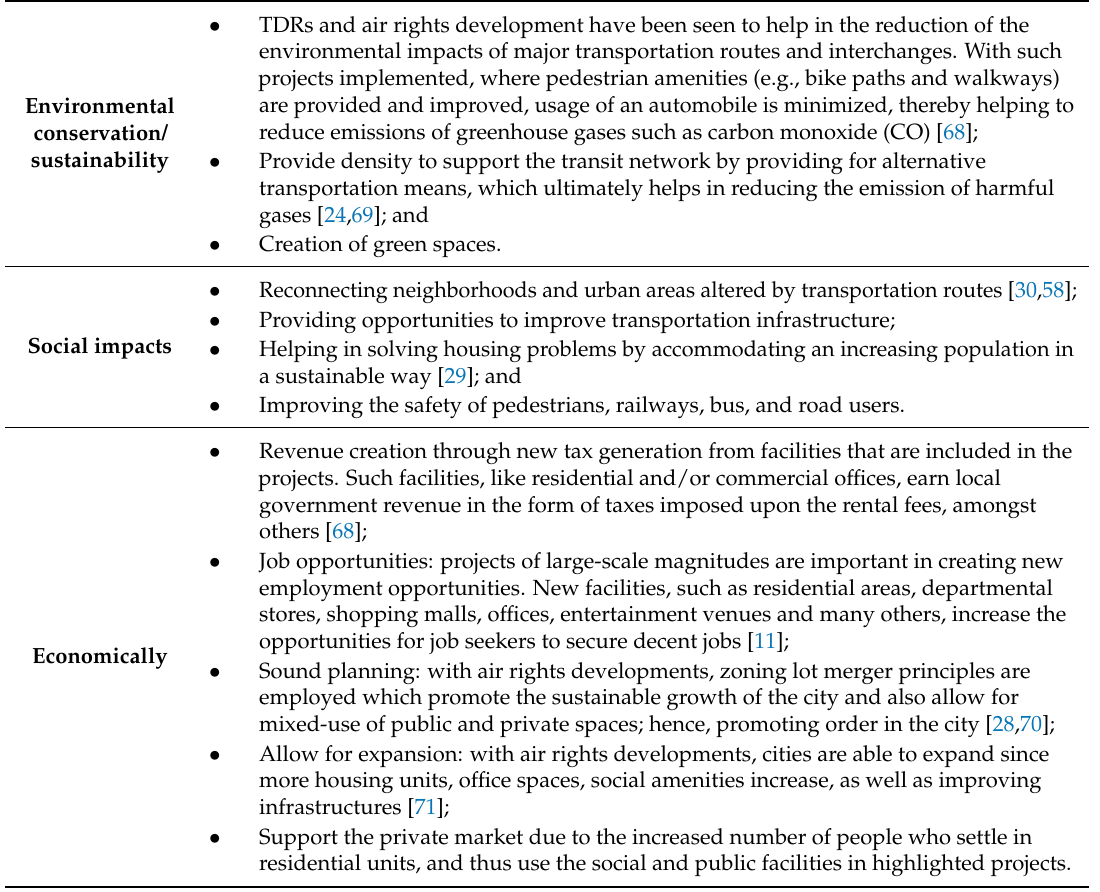
Table 1. Identified benefits of air